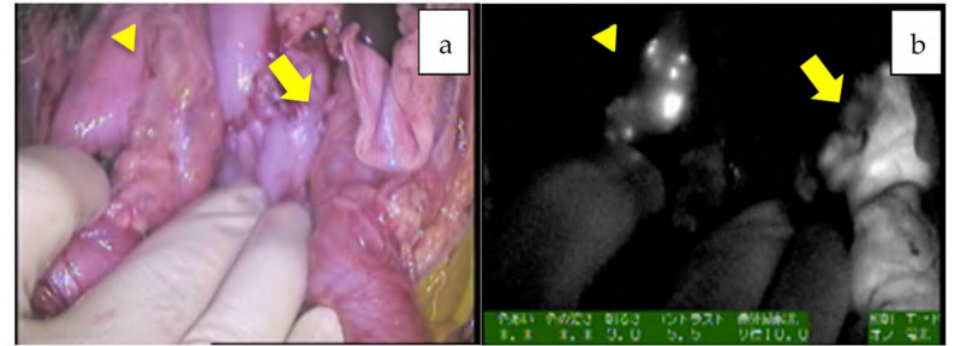
Figure 9. a , b Non-specific fluorescence in the pancreas and bowel loops. The arrowhead indicates the intense fluorescence in the pancreas, but a thorough inspection denied the presence of metastases. Non-specific fluorescence in the bowl loops was also observed (indicated by an